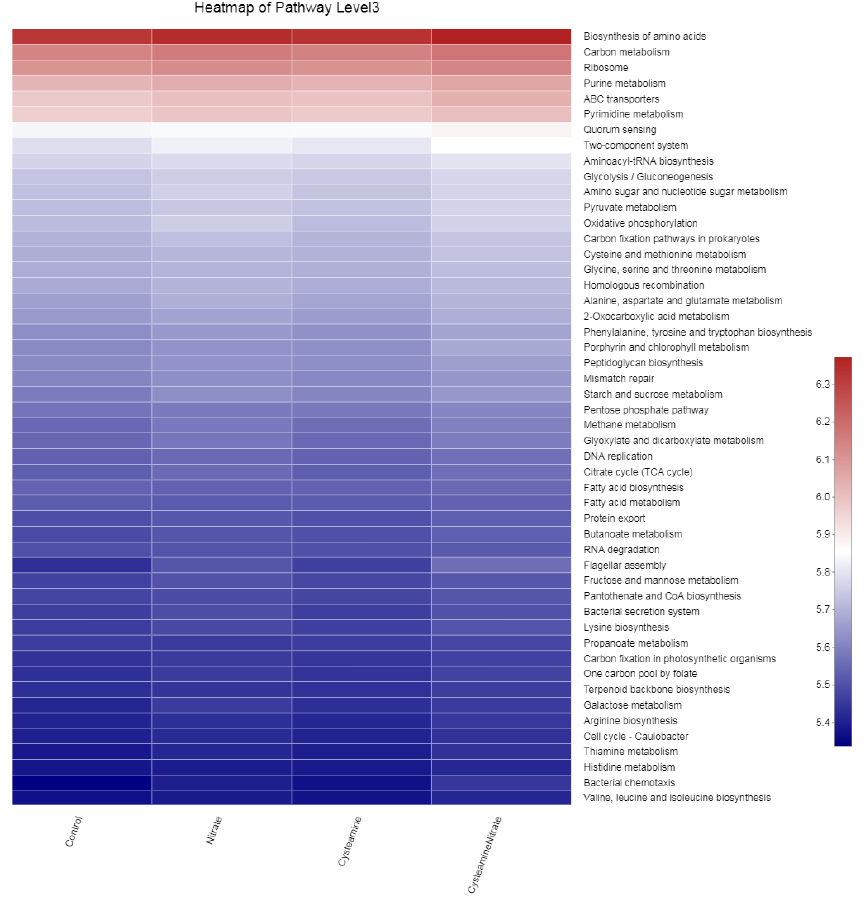
Figure 6. Top kyoto encyclopedia of genes and genomes (KEGG) enriched pathways in different treatment groups.